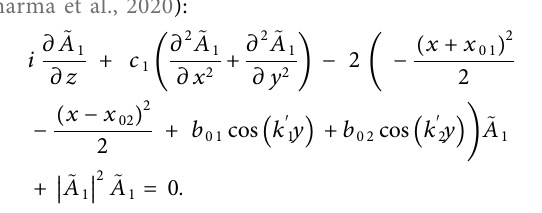
Frontiers in Astronomy and Space Sciences |